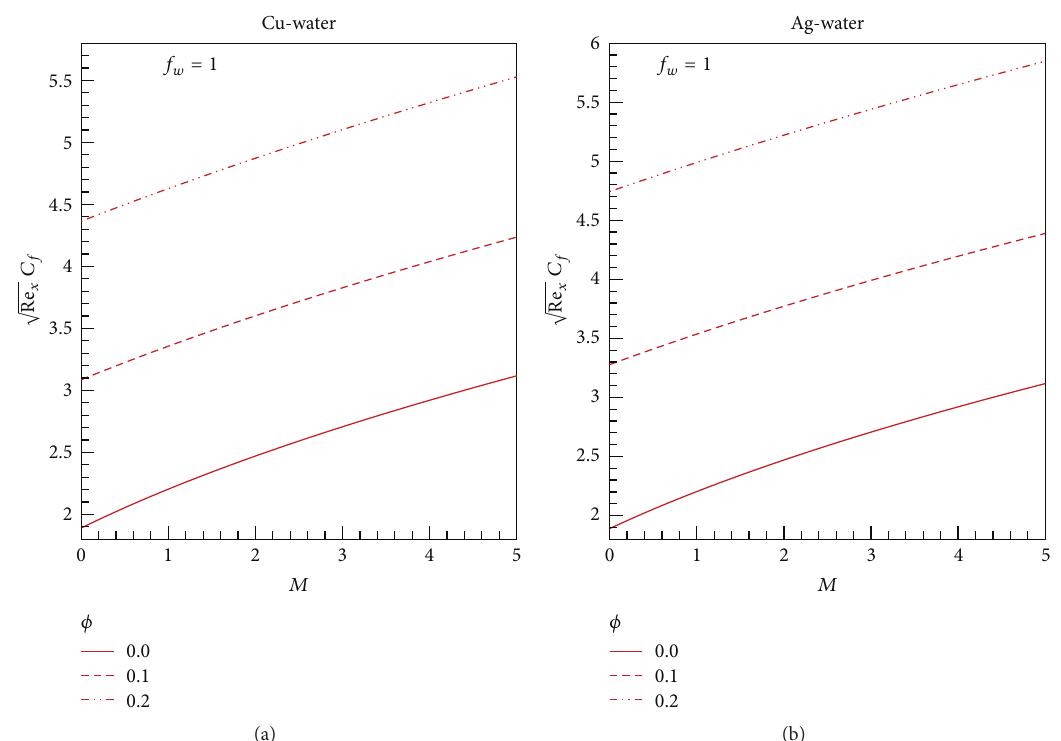
Figure 7: Variation of skin friction with volume fraction of